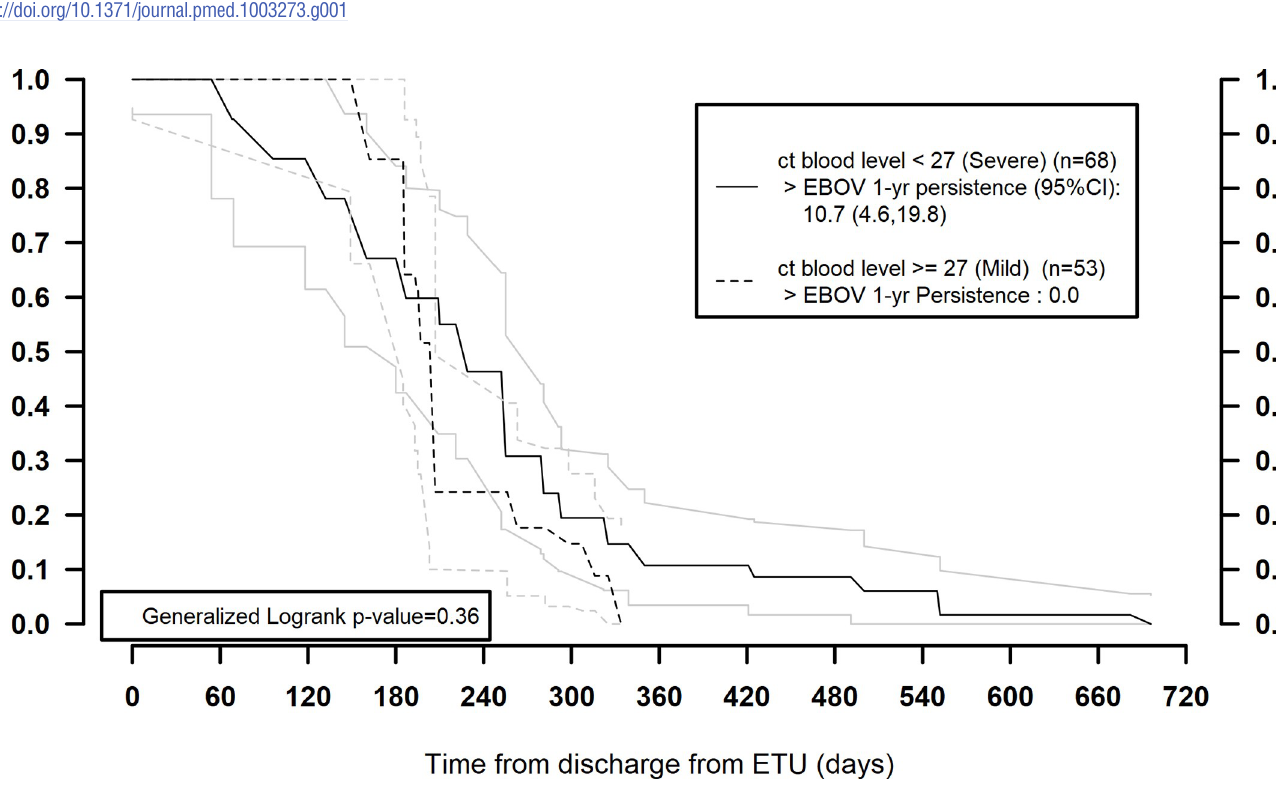
Fig 2. Survival function of EBOV RNA persistence stratified by acute/ETU blood cycle threshold values, within the sub-population with matched values available. ct, cycle threshold; EBOV, Ebola virus; ETU, Ebola treatment unit.